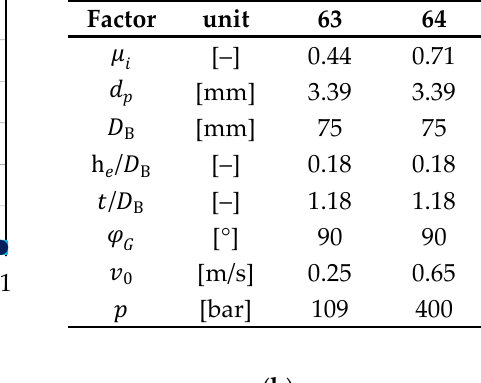
Figure 8. ( a ) Frequency distribution of normalized axial velocity with schematic illustration of decile distance 𝑠 ; ( b ) factor settings of test points 63 and 64.